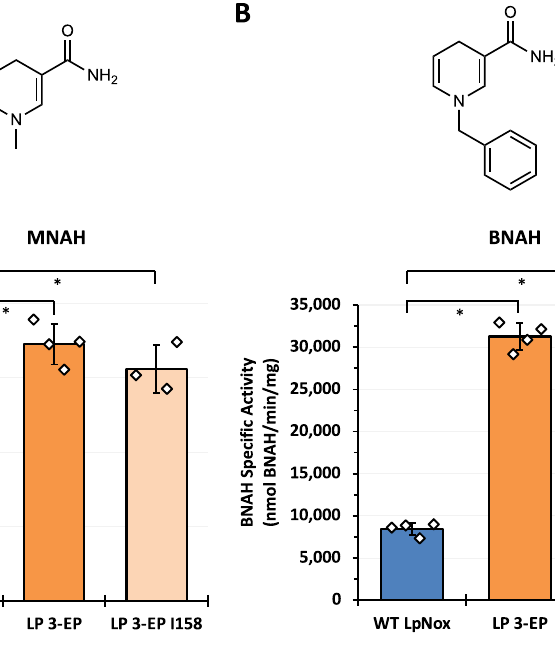
p =0.000074; WT to LP 3-EP I158, p =0.00097. B Similar to the activity trend with MNAH, Lp Noxvariant,LP3-EP(orange),showsa~4-foldincreaseinspeci fi cactivity compared to WT Lp Nox (blue) using BNAH. Furthermore, LP 3-EP I158 (beige) still showshigheractivitywithBNAHthanWT Lp Nox.Forallsamples, n =4biologically independent replicates. For statistics, WT to LP 3-EP, p =2.5 ×10 -7 ; WT to LP 3-EP I158, p =0.0014. Data are presented as mean±standard deviation. The statistical signi fi cancewasdeterminedbytwo-tail t -tests,(*: p <0.05).Sourcedataisprovided as a Source Data fi